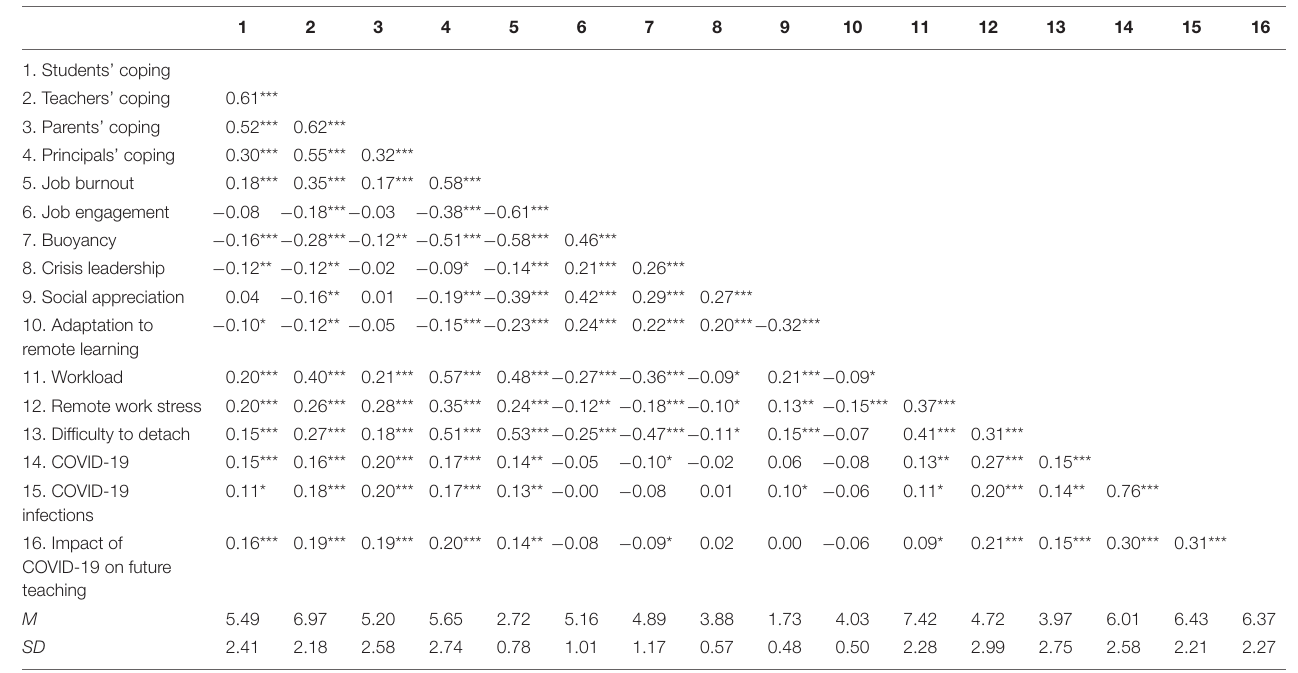
TABLE 1 | Correlation coefficients, means, and standard deviations.